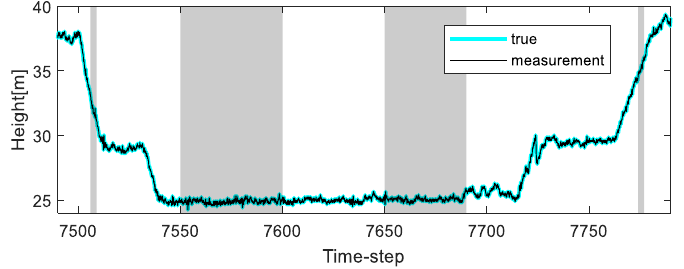
Figure 4. The true altitude trajectory and measurements of the underground parking lot under normal conditions (four shaded sections: generating measurement error).